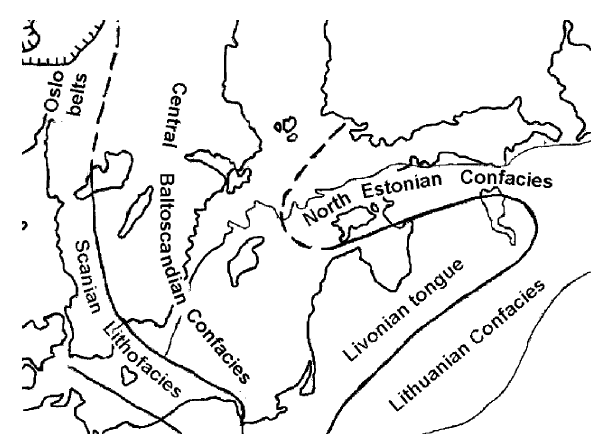
Fig. 18. Ordovician confacies belts in Baltoscandia. After Jaanusson